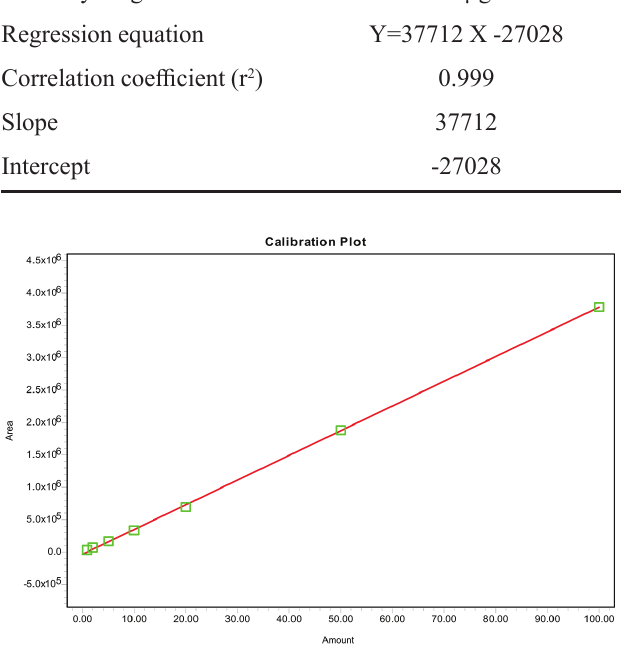
TABLE II - Linear regression data for calibration plots Parameters